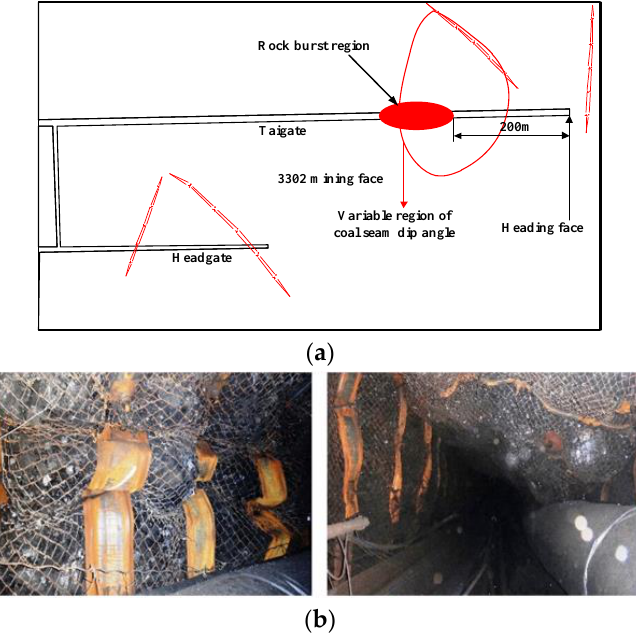
Figure 5. Rock burst region in the No. 3302 mining face and photos of the associated rock burst damage [25], ( a ) rock burst region, ( b ) roadway damage